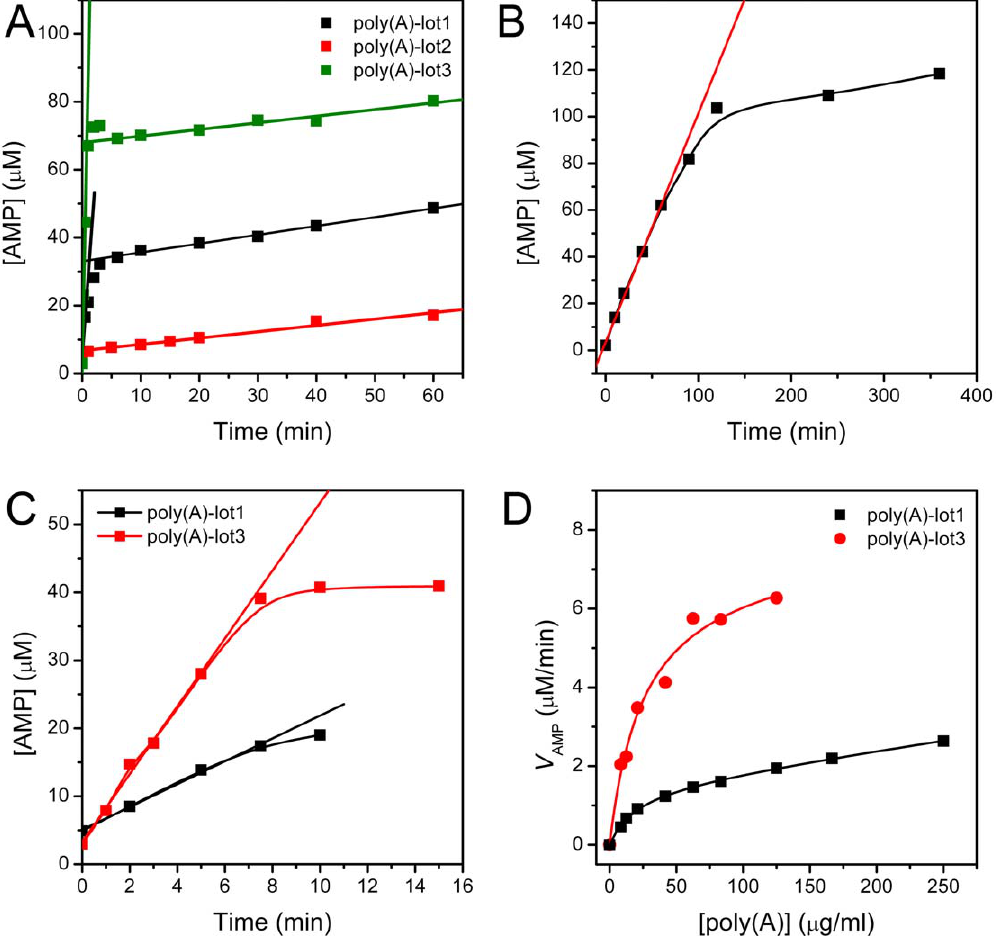
Figure 5. SEC assay of PARN using the three lots of commercial poly(A) as the substrate. (A) Time-course generation of AMP during the enzymatic reaction of PARN using the three lots of commercial poly(A) as the substrate. The enzyme concentration was 0.02 mg/ml. The fast and slow phases of the biphasic process were fitted by linear equation, and the fitted data are showed in solid lines. (B) Time-course generation of AMP when using poly(A)-lot2 as the substrate and a high enzyme concentration of 0.2 mg/ml. (C) The fast phase of AMP generation when using poly(A)- lot1 and poly(A)-lot3 as the substrate. The final concentration of PARN was 0.001 mg/ml. (D) Determination of PARN activity by fitting the experimental data using the Michaelis-Menten